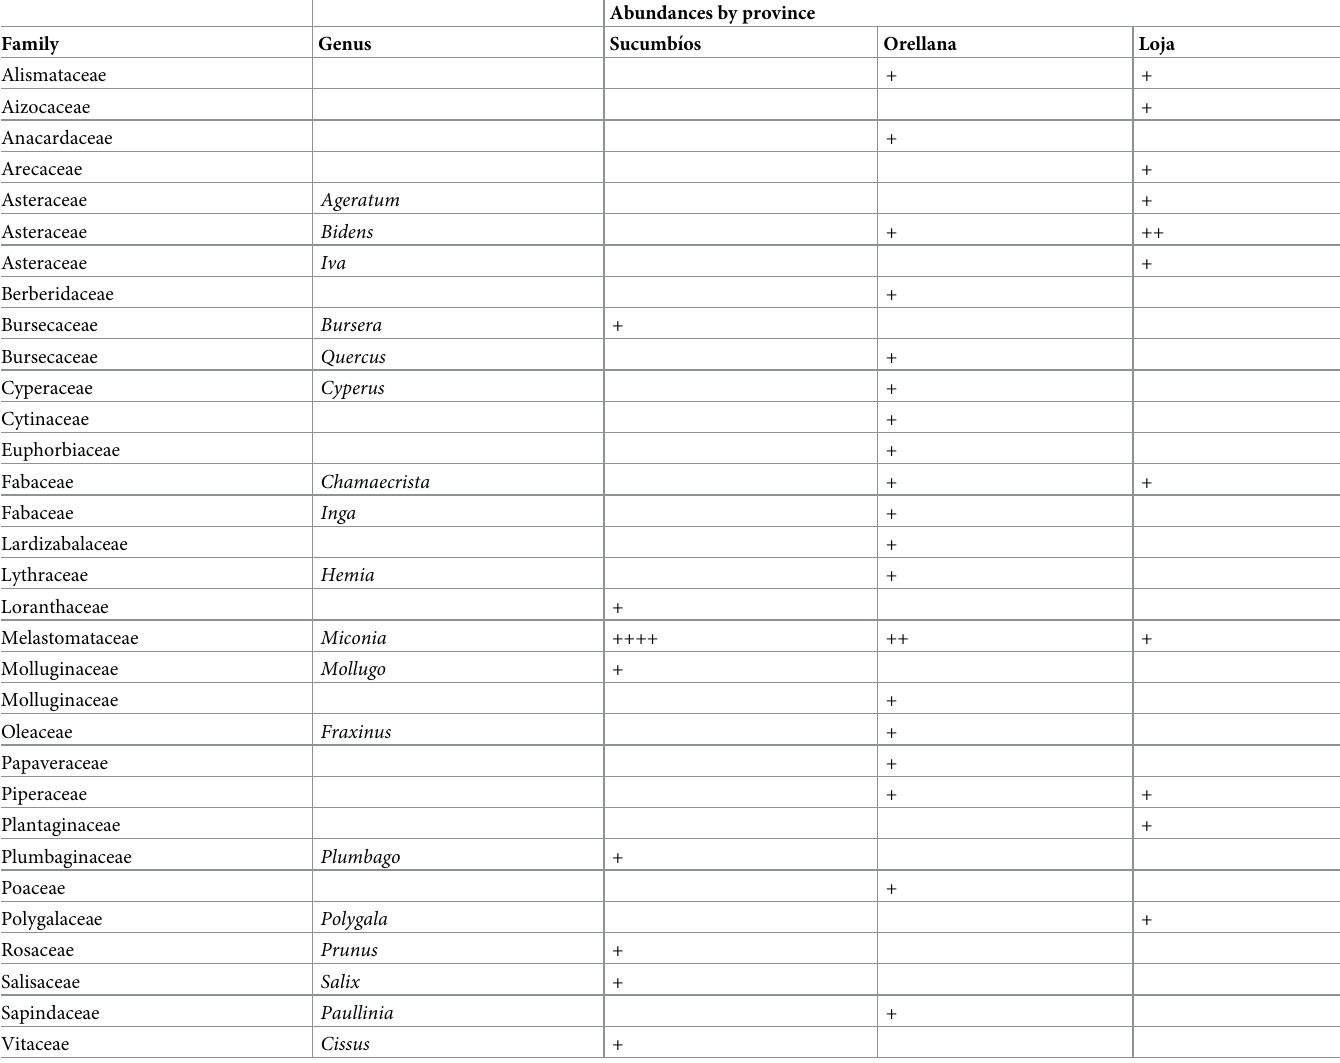
Table 2. Families, genera and their abundances of pollen grains identified by